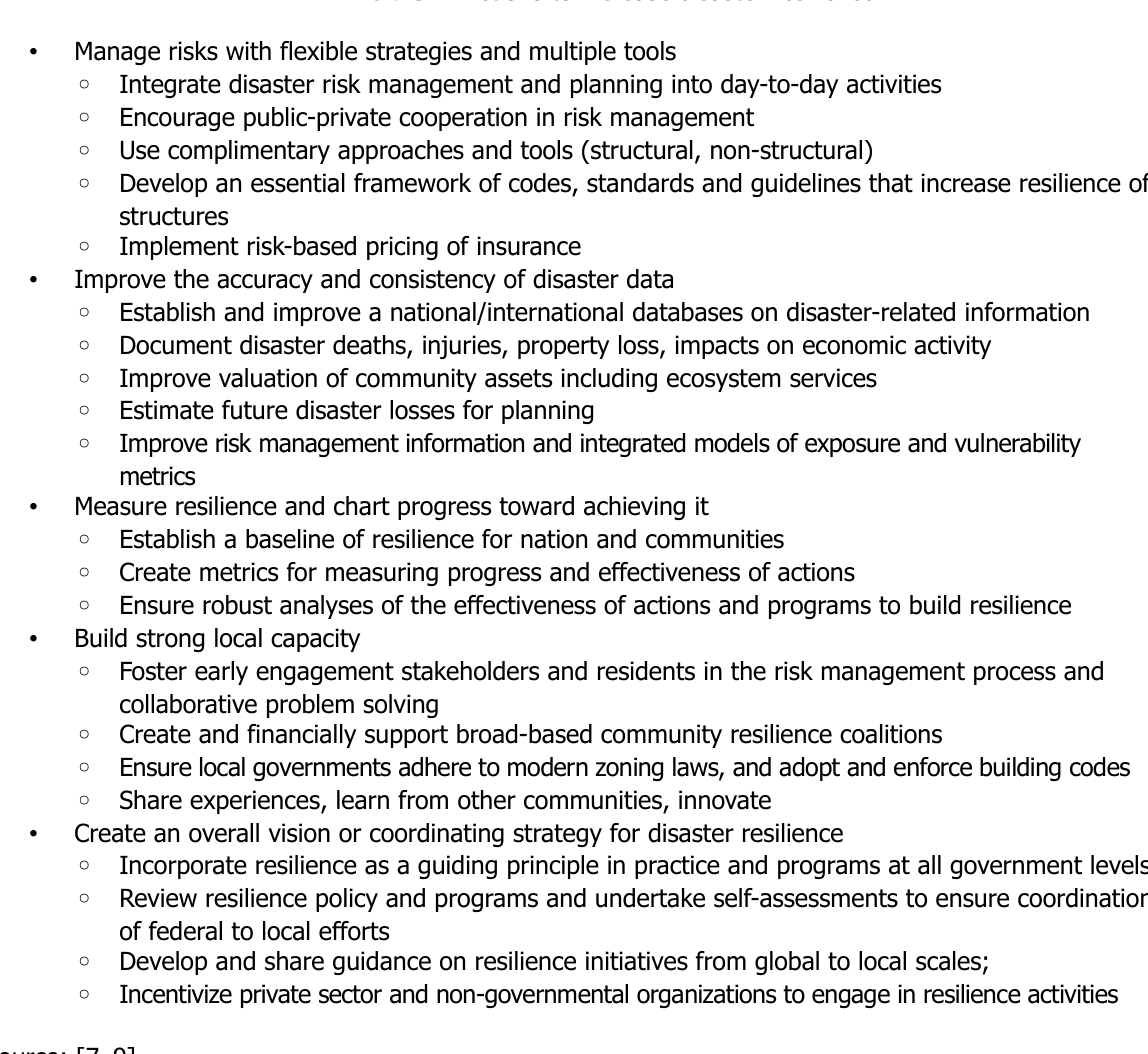
Table 1. Actions to increase disaster